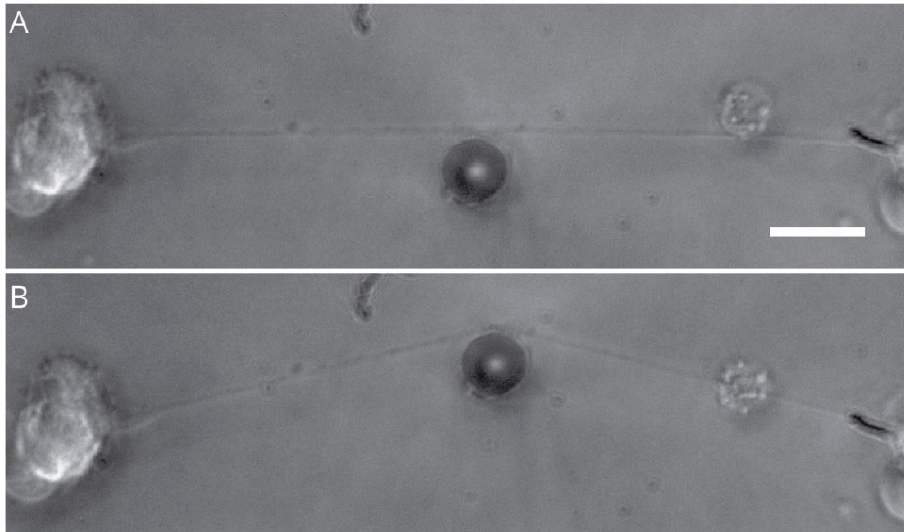
Figure 5. Stretching an individual axon. Image showing an unstretched ( A ) and a stretched ( B ) ax- on. The lateral stretching force was applied using an optical fiber cantilever. Scale bar: 20 µ m (reproduced with permission from Pramod Pullarkat, Soft Condensed Matter Group, Raman Research Institute, Bengaluru, India, eLife; 2020, 9, 1–22).